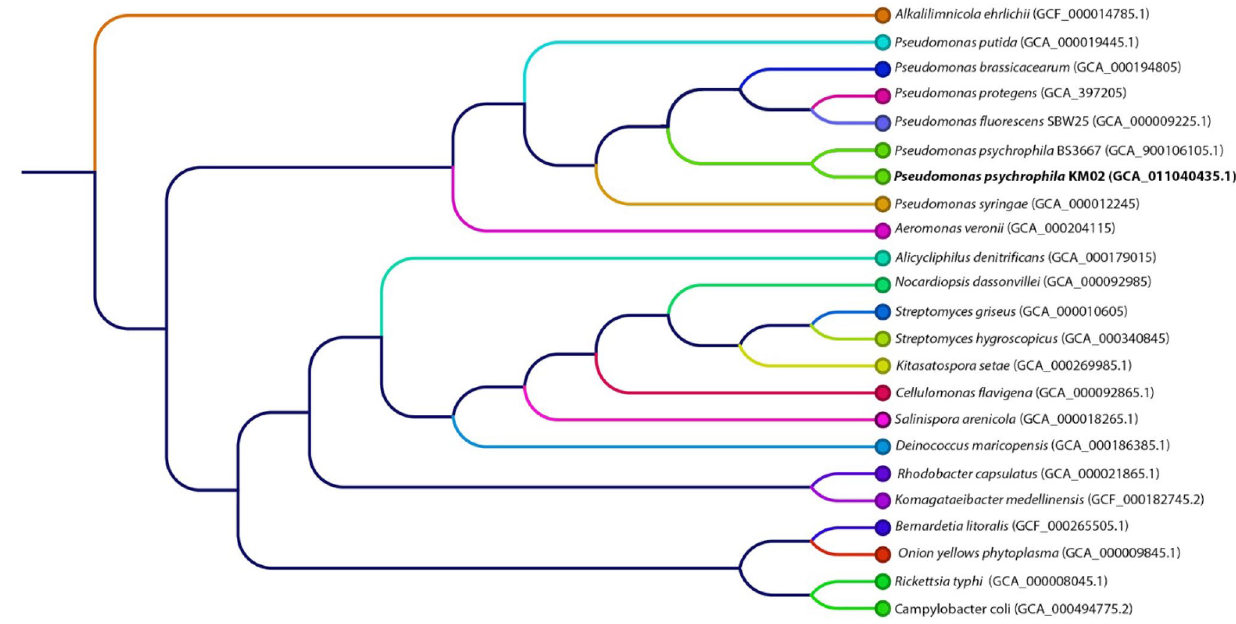
Figure 4. K-mer phylogenic tree of P. psychrophila